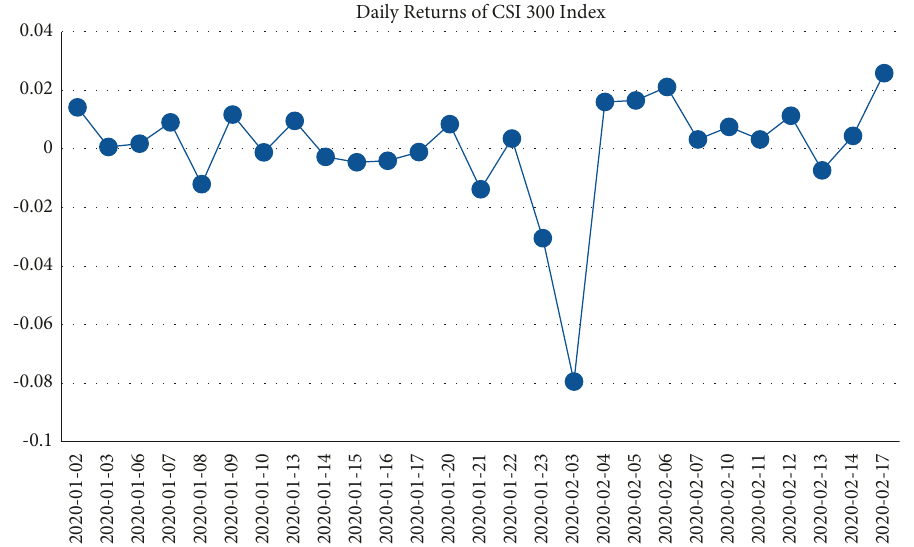
Figure 1: The daily returns of CSI 300 Index from January 2, 2020 to February 17, 2020. Note. This figure captures daily returns of CSI 300 Index from January 2, 2020 to February 17, 2020. X -axis is the timeline of COVID-19, which sets Wuhan lockdown (January 23, 2020) as the � 0 ) . Y -axis refers to daily returns of CSI 300 Index. event day ( T 0 Table 1: Descriptive statistics for the test and control